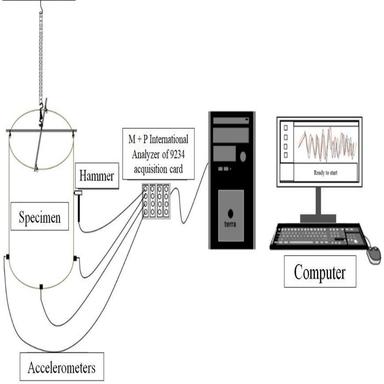
Experimental modal analysis set-up.